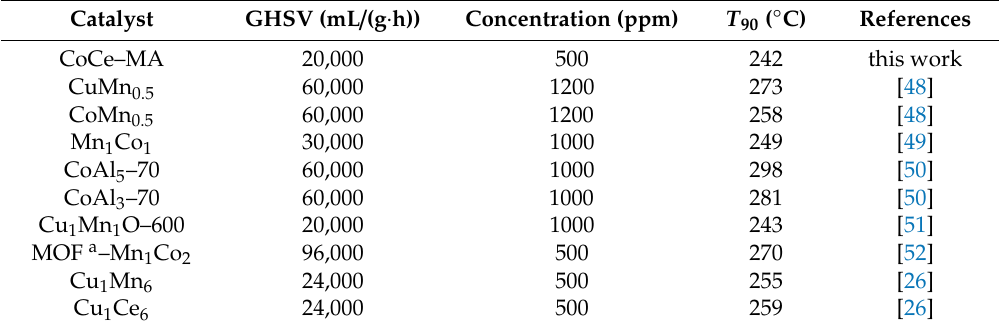
a MOF: metal–organic